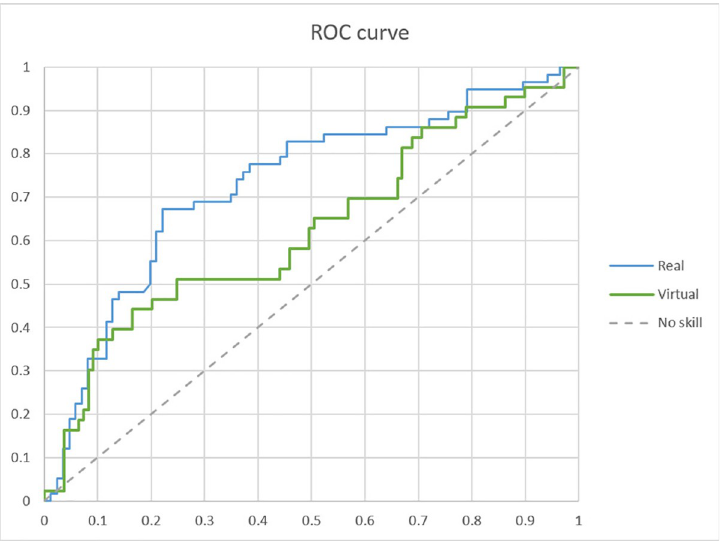
Fig 6. ROC curve of the arousal recognition model in both the real and the virtual museum conditions.